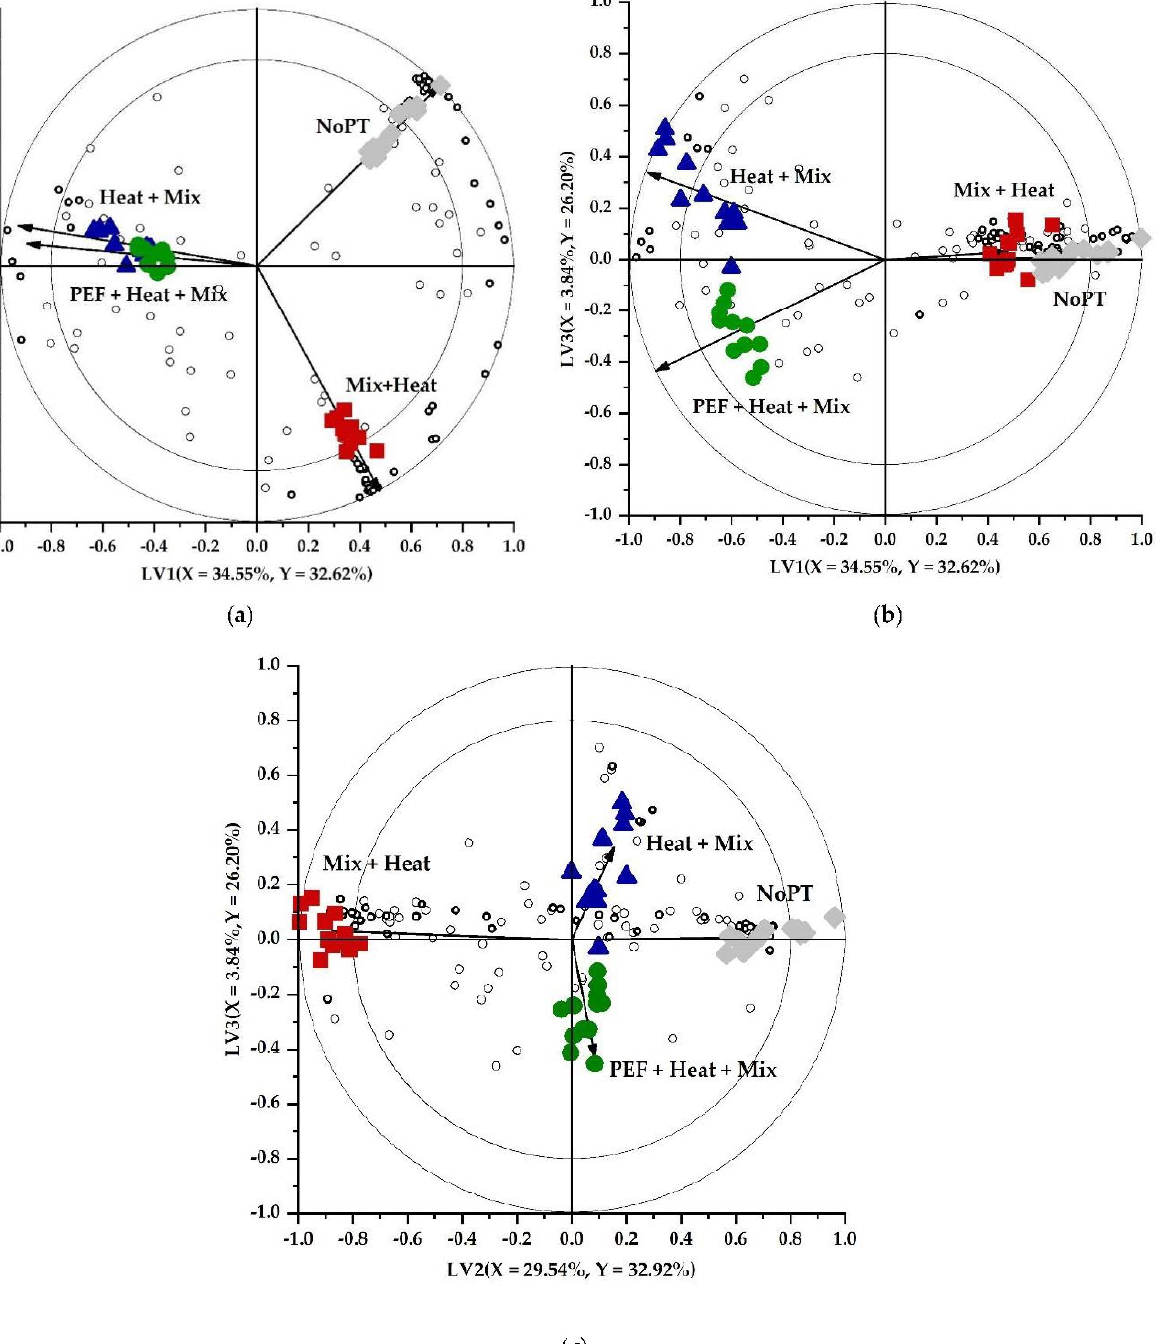
Table 2. VID, identity, chemical class and RI of markers (|VID| ≥ 0.800) for differently pretreated Brussels sprouts samples a .